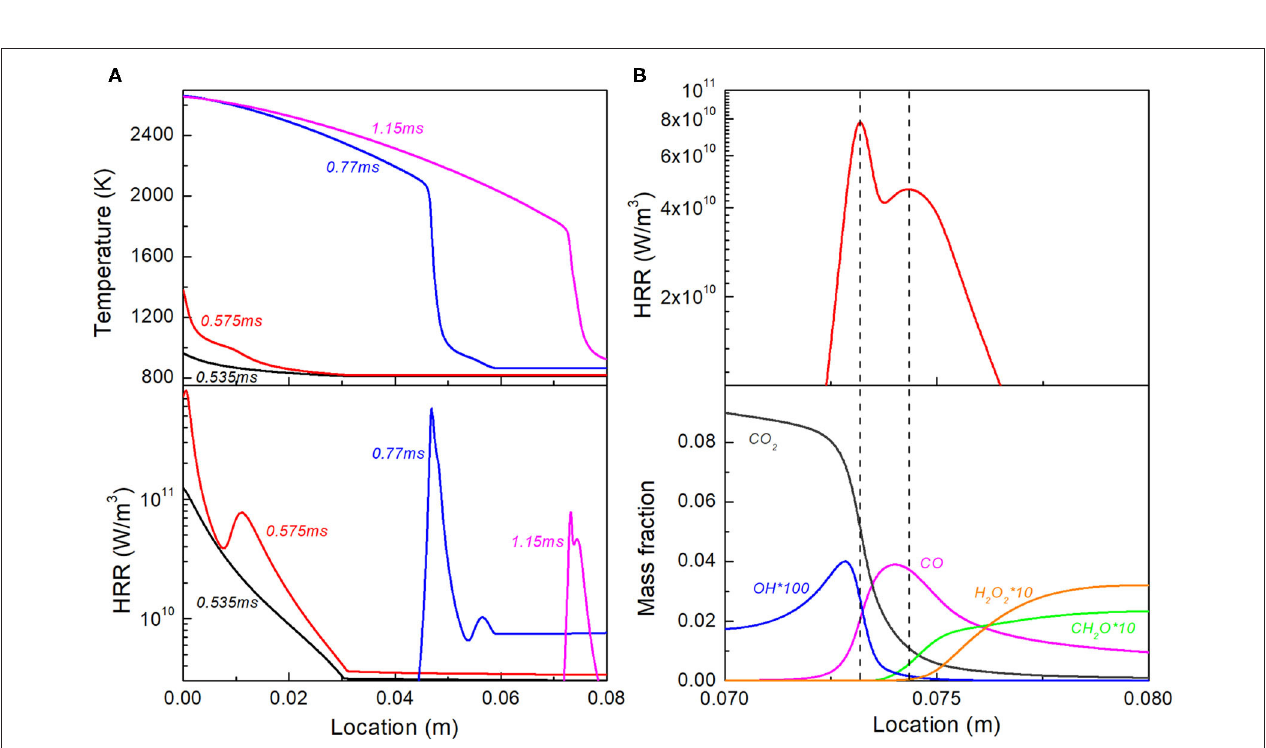
FIGURE 8 | (A) Temperature and heat release rate profile at selected time instants for Case 6; (B) Double peak heat release and profiles of representative species for reaction front at t = 1.15ms.